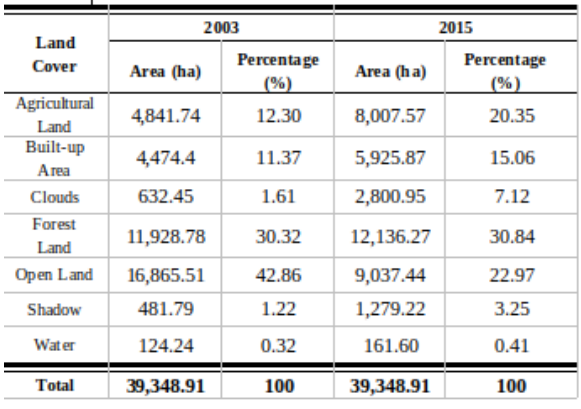
Table 2. Area and percentage for each land cover type for the